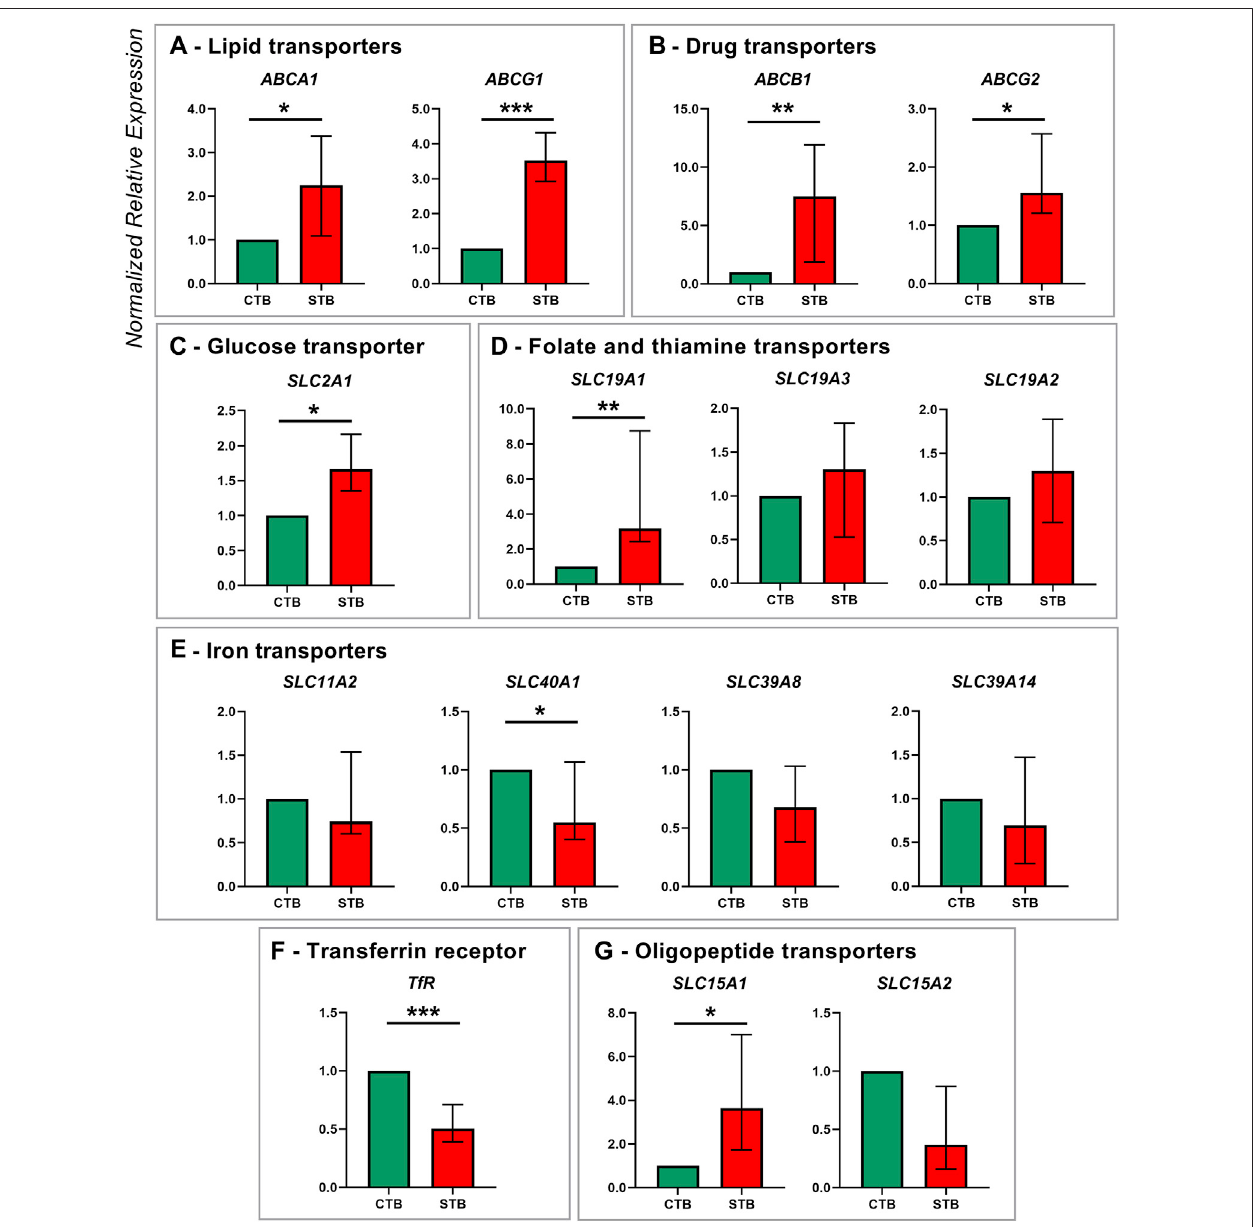
FIGURE 1 | Membrane transporter gene expression in human term primary CTBs and upon spontaneous differentiation to STB in vitro . mRNA expression was evaluated by qPCR analysis for members of the following transport classes: lipids (A) , drugs (B) , glucose (C) , folate and thiamine (D) , iron (E) , and peptide (G) ; additionally, expression of the iron uptake receptor was assessed (F) . Target gene expression was normalized to the reference gene YWHAZ and the results are shown as median with IQR expression in differentiated cells relative to the undifferentiated counterpart; n ≥ 7 for each stage. Statistical signi fi cance was evaluated using nonparametric t-tests (Mann-Whitney test): * p ≤ 0.05, ** p ≤ 0.01, *** p ≤ 0.001.